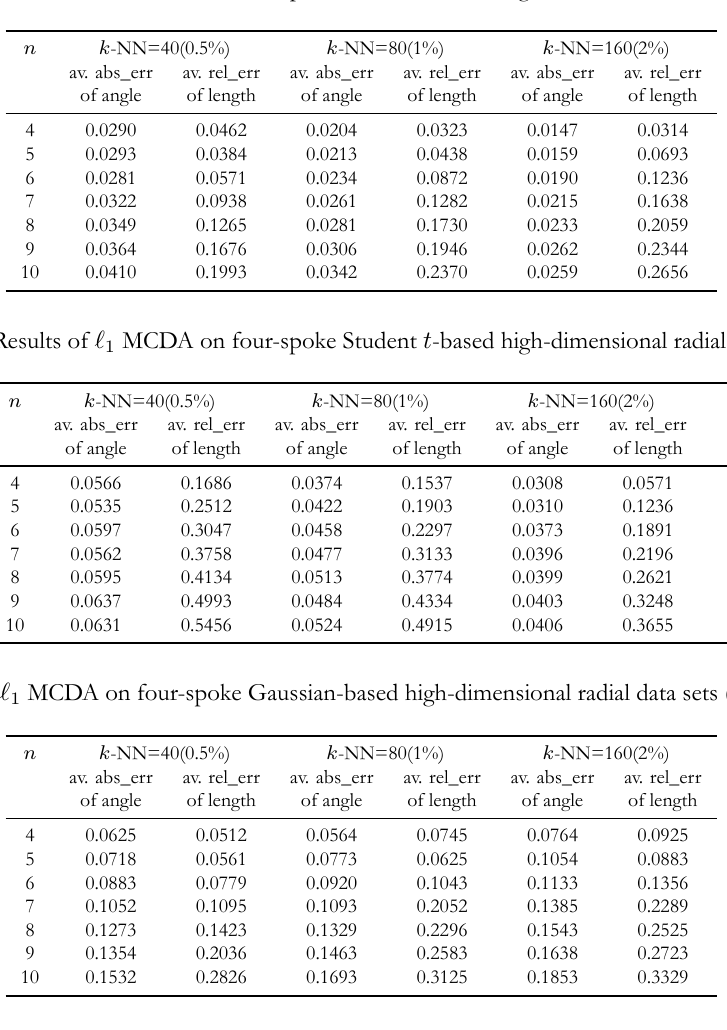
Table 5: Results of ℓ 1 MCDA on four-spoke Gaussian-based high-dimensional radial data sets